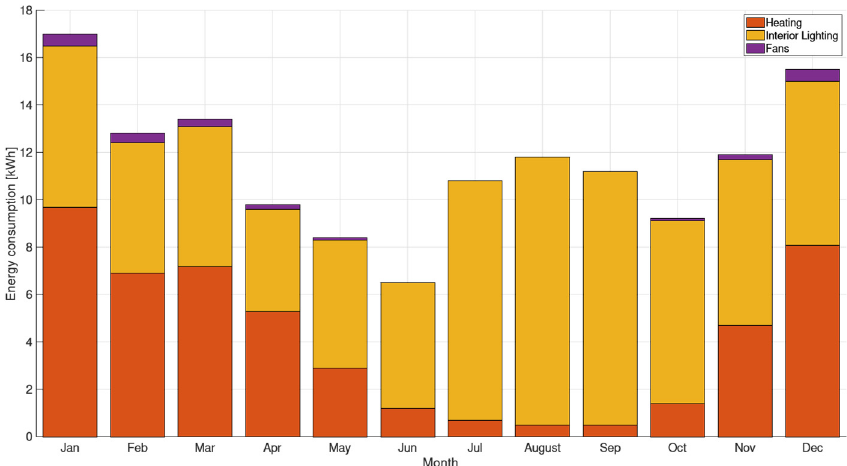
Figure 16. Monthly electricity consumption by the major required loads.